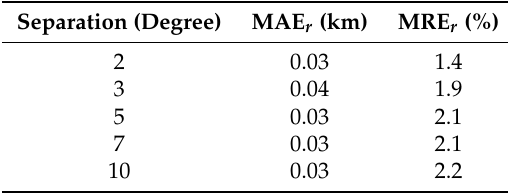
Figure 12. Detection accuracies of FNN and CBF. The detection is deemed to be correct only when the source number and the azimuths of two sources are estimated correctly. The accuracy is defined as the ratio of the number of accurate detections and the number of test samples. Table 5. MAE r and MRE r comparison under different source separations on